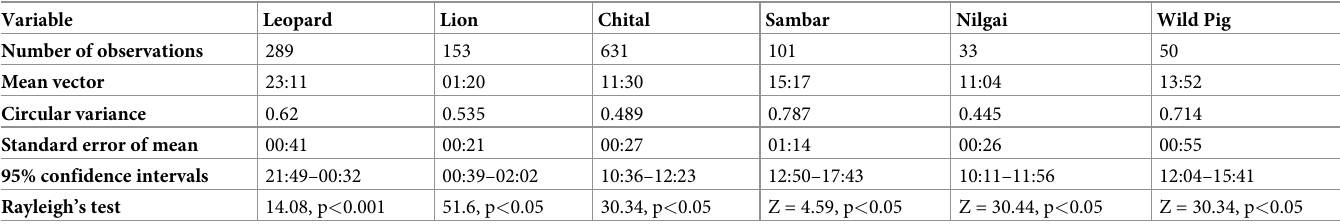
Table 1. Circular statistics of activity pattern of leopard, lion and their prey in